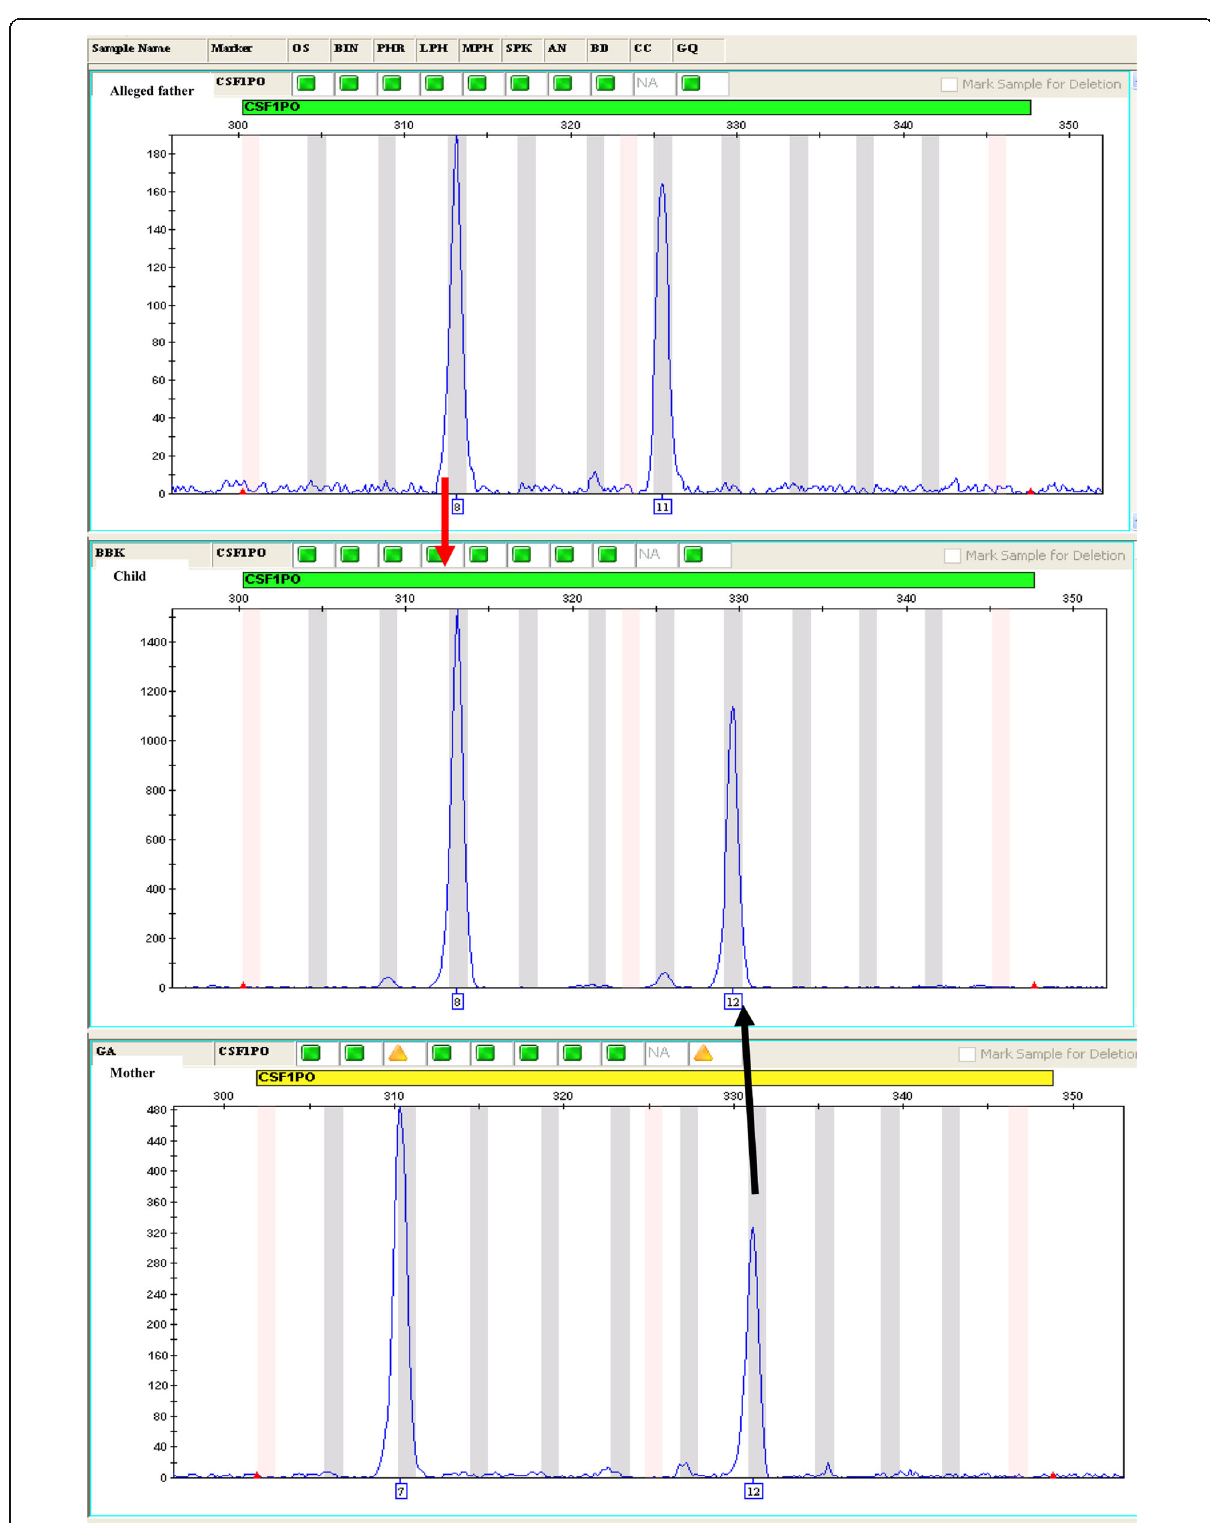
Fig. 1 Inclusion of paternity for the trio 13: example of allele correspondence (allele 8) between alleged father and child for the locus